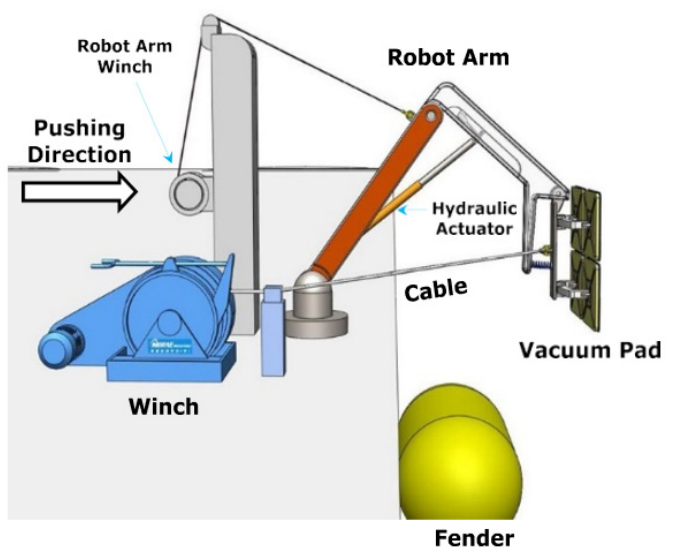
Figure 3. Schematic diagram of the design of the automated ship-to-ship docking system (adapted with permission from Ref. [27]. Copyright 2014 YongYook, Kim).